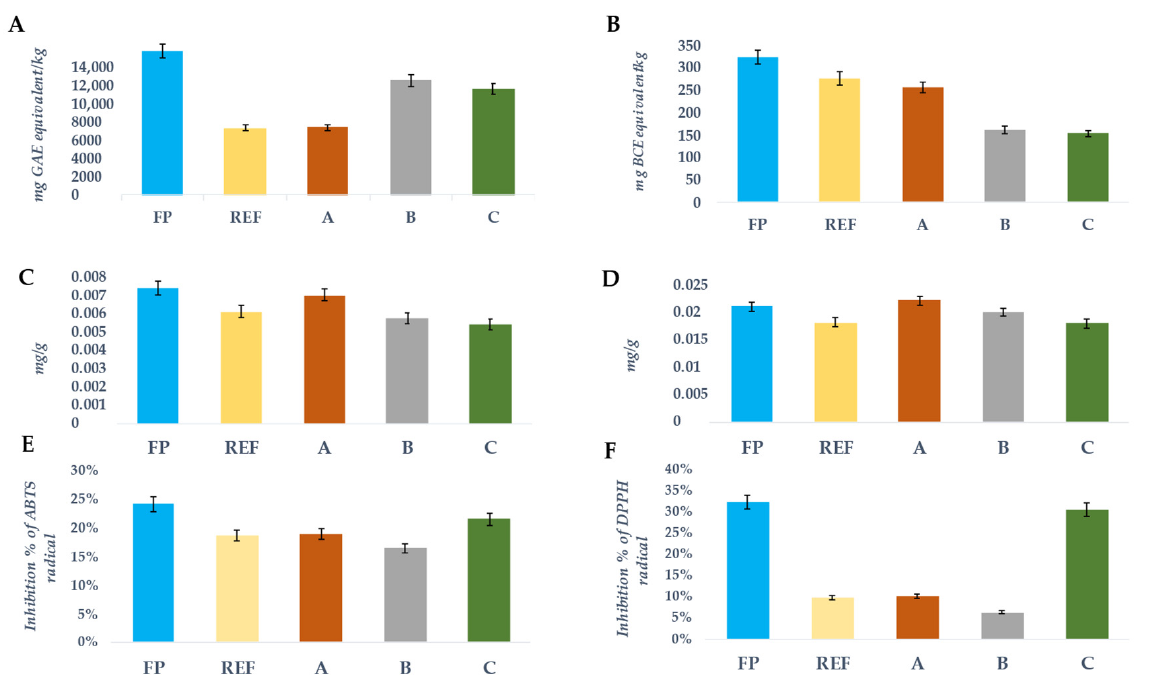
Figure 5. Histograms of total phenolic content ( A ) expressed in mg GAE/kg ± SD; total carotenoid content ( B ) expressed in mg BCE/kg ± SD; chlorophyll a ( C ) and chlorophylls b ( D ) content expressed in mg/g ± SD; ABTS ( E ) and DPPH ( F ) assays expressed as Inhibition % ± SD, evaluated in fresh and packaged pumpkin samples, during shelf-life. FP: Fresh pumpkin (light blue trace); REF: polyethylene (yellow trace); A: biodegradable cellophane from regenerated cellulose (orange trace); B: biofilm obtained from maize starch, cassava, eucalyptus (grey trace); C: poly-lactate obtained from maize starch (green trace).